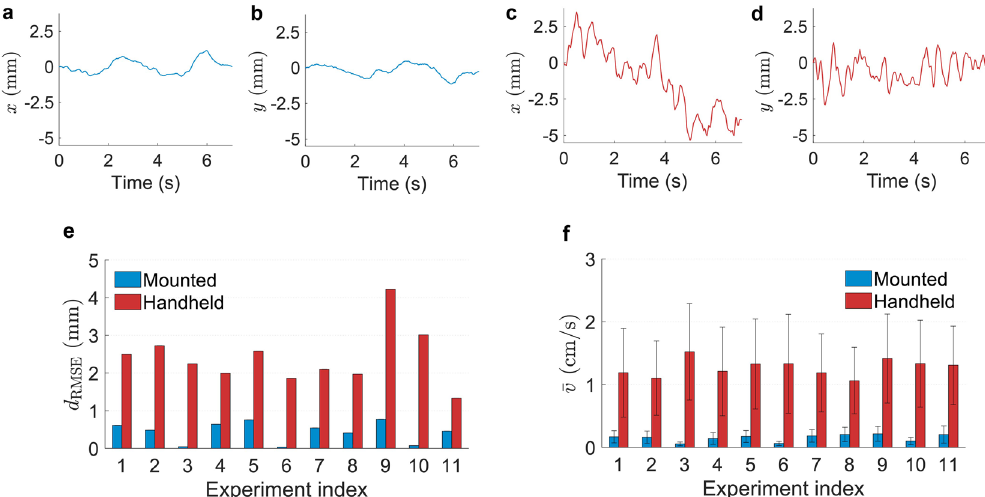
Figure 4. Motion detection with ECC technique and statistical comparison of calculated on-surface speeds for mounted and handheld measurements. Positions of the beam along ( a ) horizontal and ( b ) vertical axes in a mounted experiment. Positive direction in horizontal displacements ( x ) corresponds to right-side orientation in real world coordination. Positive direction in vertical displacements ( y ) corresponds to downside orientation in real world coordination. Positions of the beam along ( c ) horizontal and ( d ) vertical axes in a handheld experiment. In ( a – d ) data of experiment index 1 is shown. Overview of the ( e ) root-mean-square-error distance from average location of each experiment and ( f ) on-surface speeds (mean±standard deviation) for the entire time trace of each